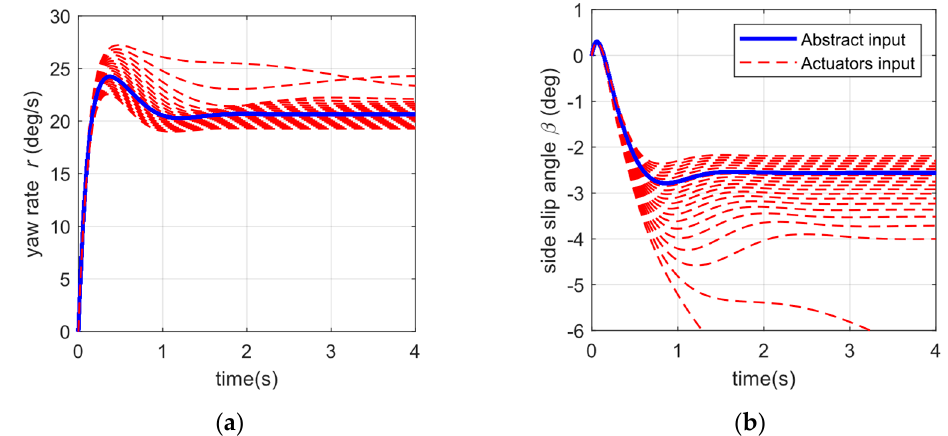
Figure 5. Secondary effects for different distributions for a left turn at 80 km/h and 60 deg steering wheel input. ( a ) Yaw rate responses; ( b ) Side slip angle responses.